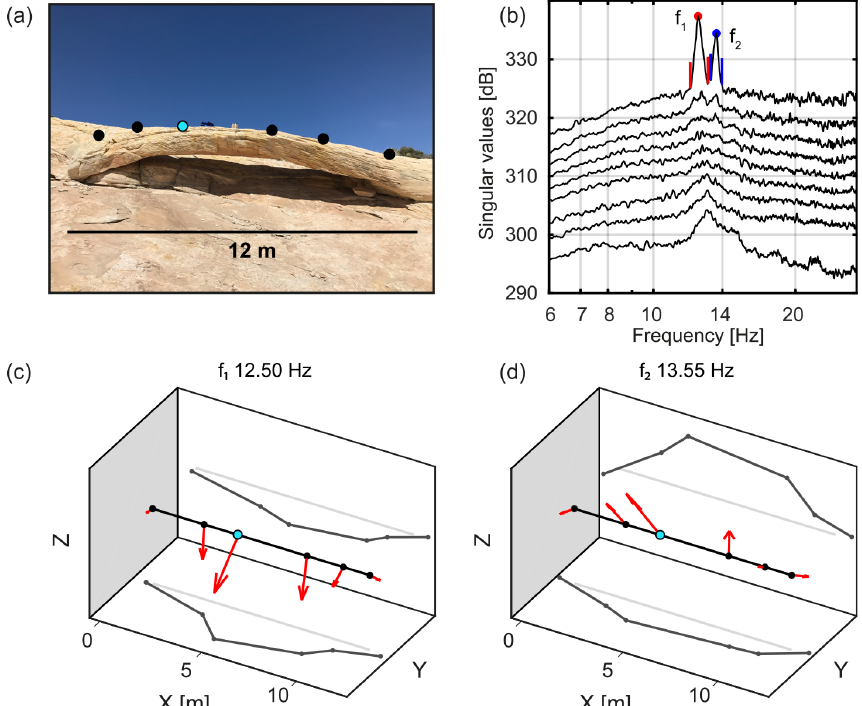
Figure 4. Modal analysis of Squint Arch. (a) Photograph of Squint Arch during the array measurements using nodal geophones and (b) sin- gular value plot of EFDD analysis showing the first nine singular values. Solid markers indicate the resonant peaks, while vertical colored lines indicate the extent of the corresponding mode bell. (c) Projections of the mode shape at 12.5Hz onto the Y – Z and Y – X plane. (d) Pro- jections of the mode shape at 13.6Hz. Mode shapes are normalized to the station indicated by a cyan marker. The array geometry in panels (c) and (d) (black dots and line) is simplified for illustration